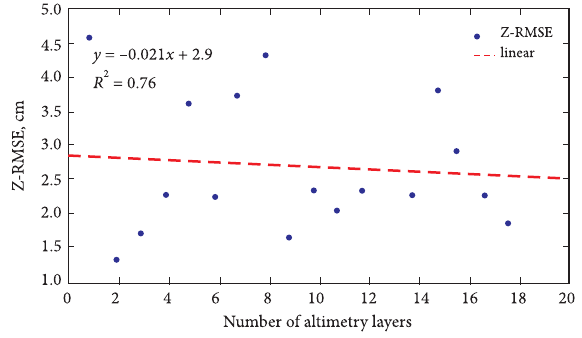
Fig. 6. RMSE (Height) changing rate by increasing altimetry layers